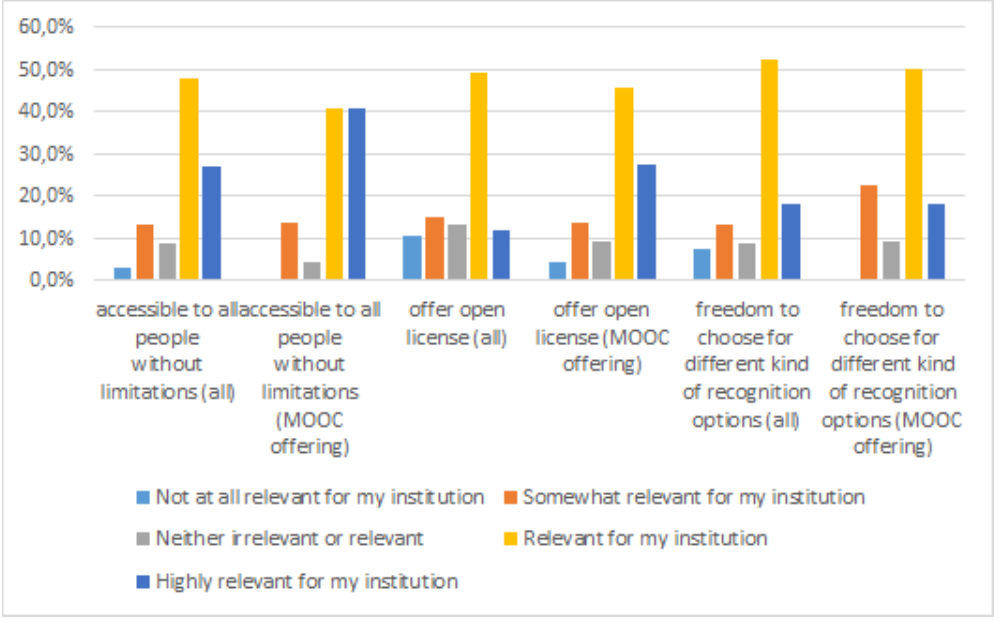
Figure 10b . The importance of the open dimension in MOOCs (dimension 1, 2 and